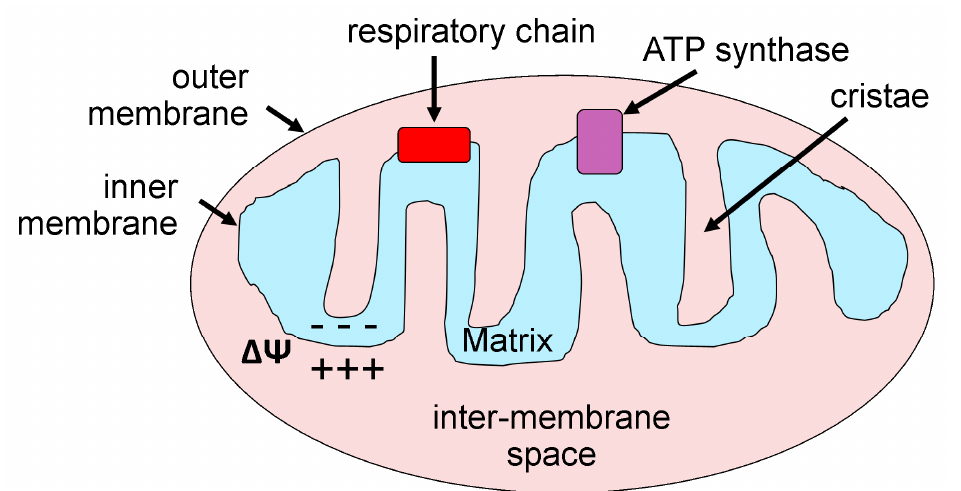
Figure 1. Principal structural and functional components of cellular mitochondrion. ATP: Adenosine triphosphate. A basic mitochondrial feature is the maintenance of membrane potential across the inner